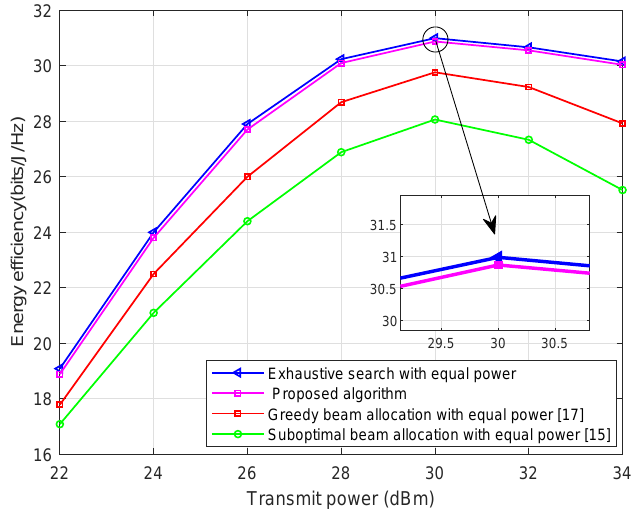
Figure 2. EE versus transmit power with α = 2, U = 20.